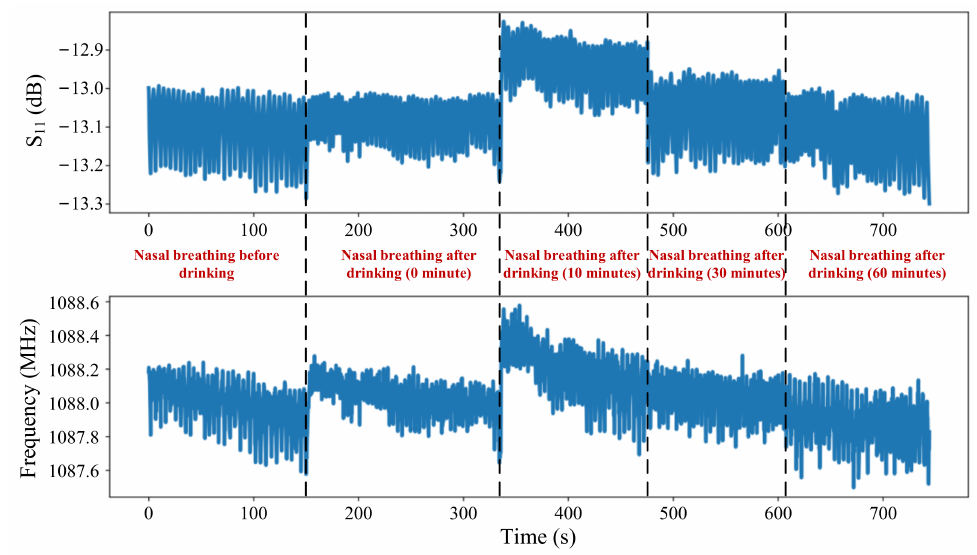
Figure 13. S 11 and frequency responses with nasal breathing time before water intake and after water intake for 0 min (immediately), 20 min, 40 min and 60 min.